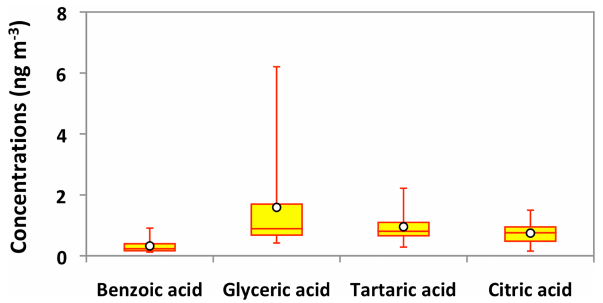
Figure 13. Molecular distributions of aromatic acids and polyacids in PM 2 . 5 aerosols collected in central Alaska. See Fig. 5 for the description of the box-and-whisker